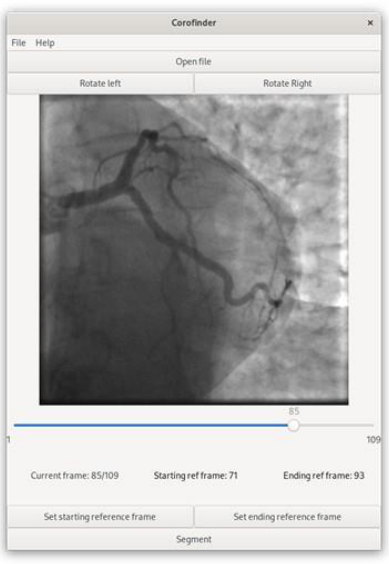
Figure 1. The figure shows the logical workflow behind the software’s graphical interface.